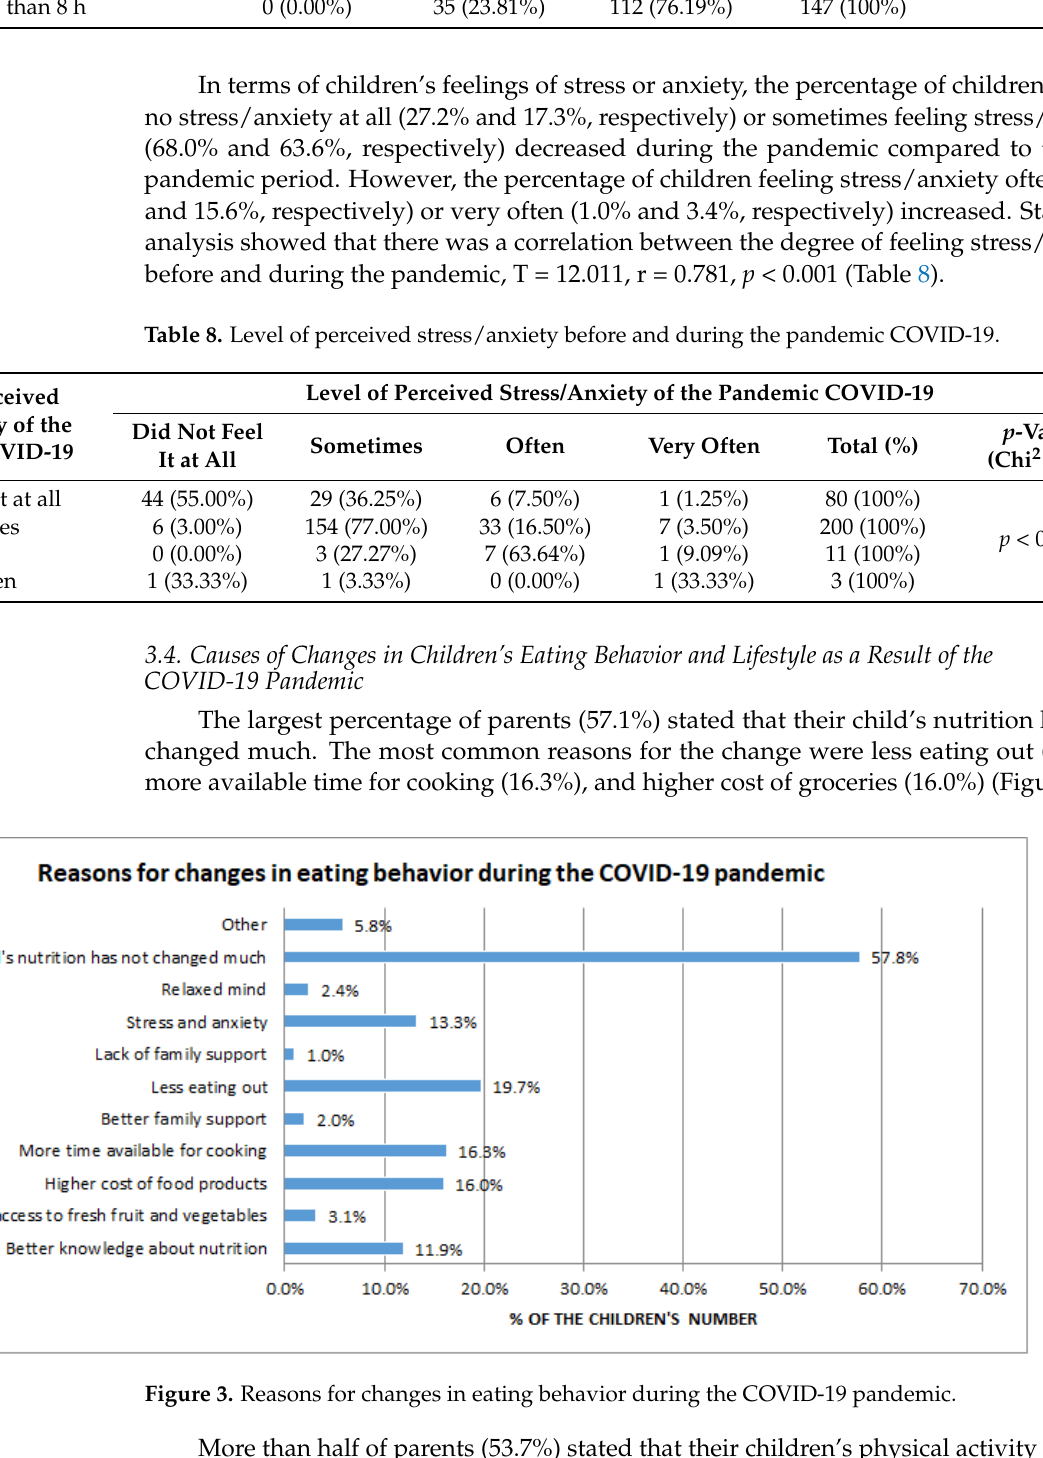
Table 7. Length of time spent sleeping before and during the COVID-19 pandemic.